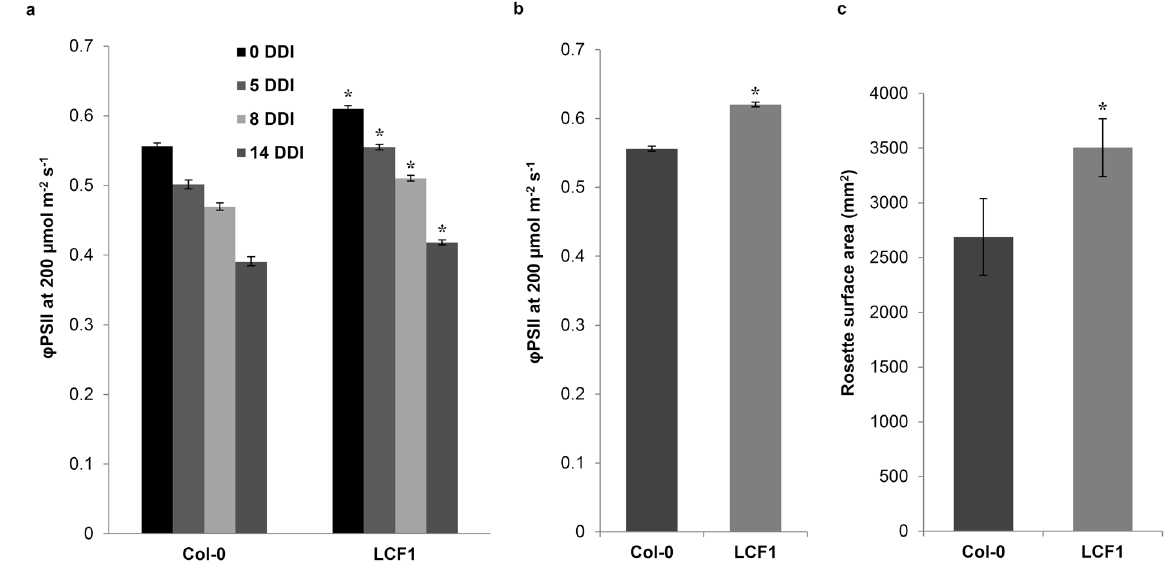
Figure 7. Dark induced senescence of Col-0 and LCF1 plants. Plants were initially grown at standard light conditions, and were transferred to complete darkness at otherwise unchanged conditions at 21 days after germination. ( a ) ϕ PSII measurements after 0, 5, 8 and 14 days of dark incubation (DDI), respectively. ( b ) Quantification of ϕ PSII after 14 days of recovery in the light. ( c ) Quantification of rosette surface area after 14 days of recovery in the light. Asterisks ( * ) represent a significant difference with Col-0 ( p < 0.05 for ϕ PSII values and p < 0.1 for rosette surface area values). Error bars represent SEM values (n = 7 per